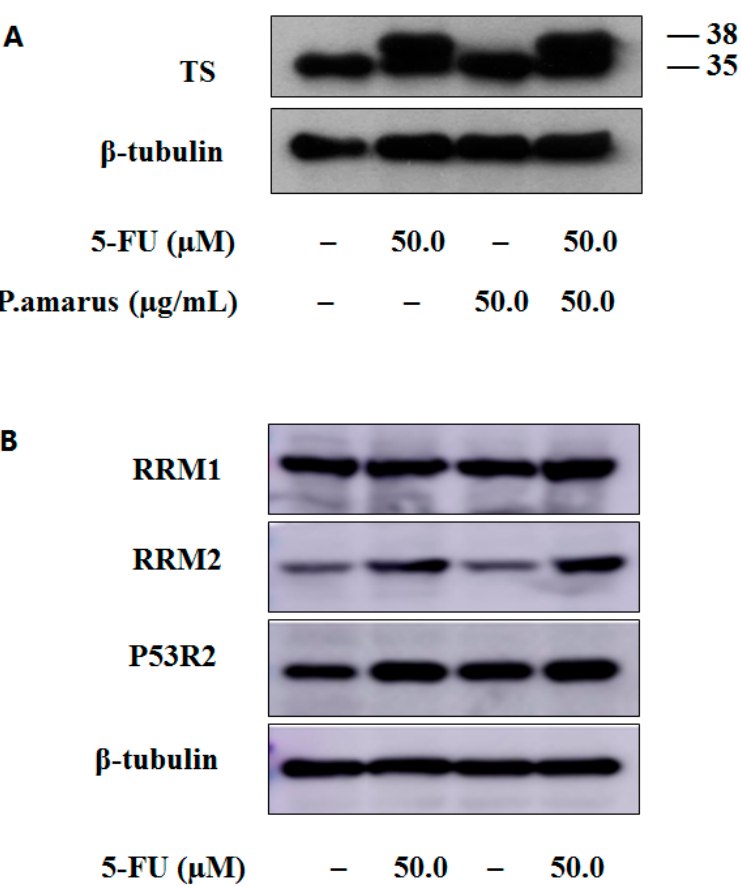
Figure 5. Western blot analysis in HepG2 cells: ( A ) expression of TS; and ( B ) expression of ribonucleotide reductase subunits M1 (RRM1) and M2 (RRM2), P53-controlled ribonucleotide reductase (P53R2). Table 3. Levels of dRNs in HepG2 cells of every group (pmol/10 6 cell).